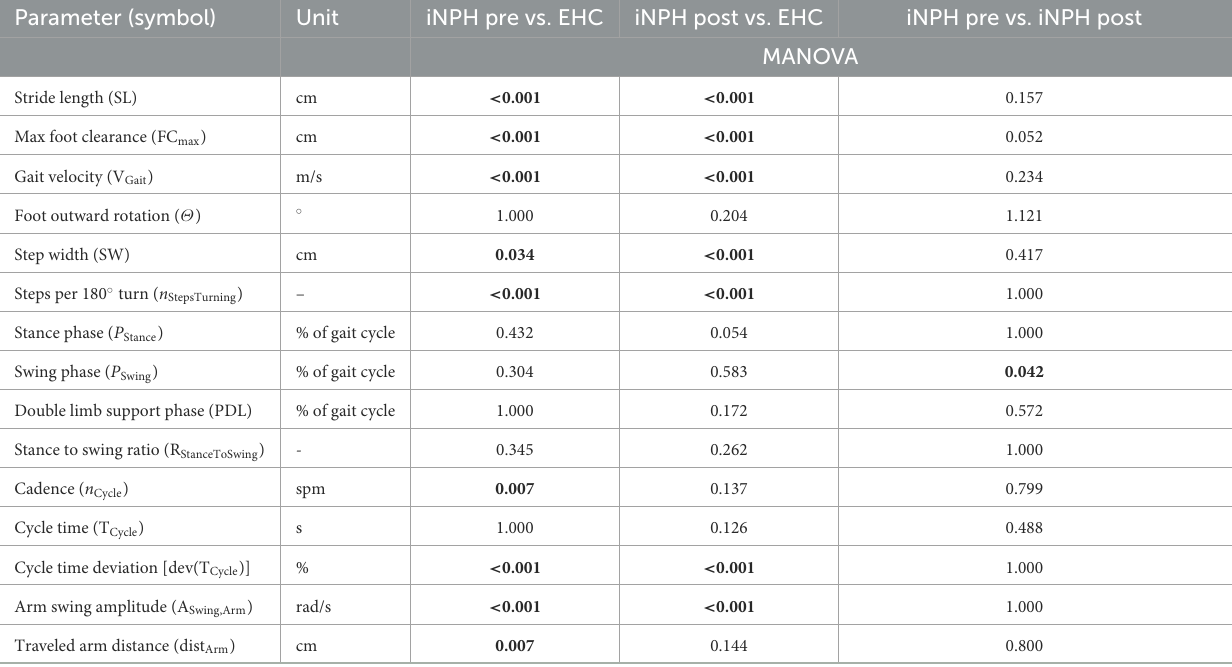
TABLE 3 Spatial and temporal gait parameters for the evaluation of a 72-h monitoring using wearable inertial measurement unit (IMU) sensors. Parameter (symbol) Unit iNPH pre vs. EHC iNPH post vs. EHC iNPH pre vs. iNPH post